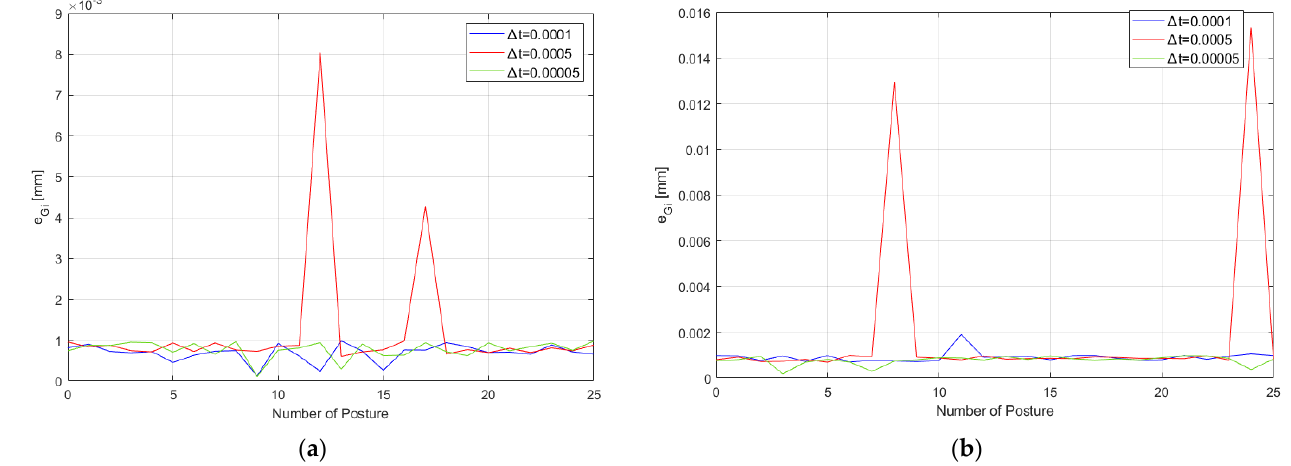
effector ( b ) variable orientation for the end-effector.